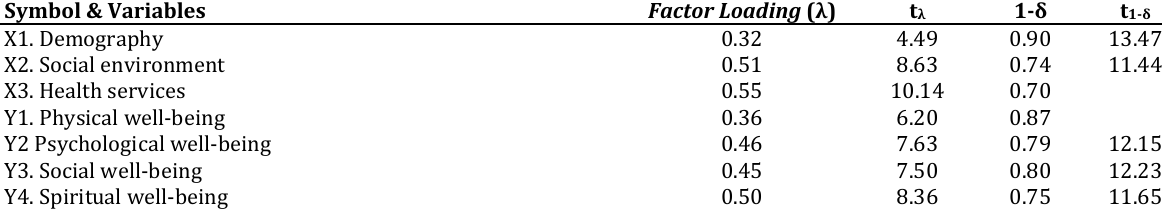
Table 3. Significance of the CFA model on Elderly Well-being Symbol &